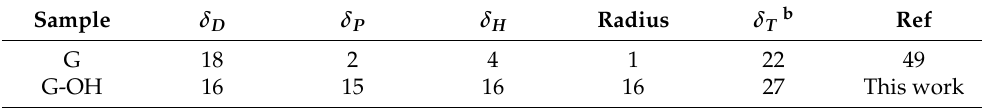
Table 2. Hansen solubility parameters and sphere radius for pristine G and G-OH adducts a .